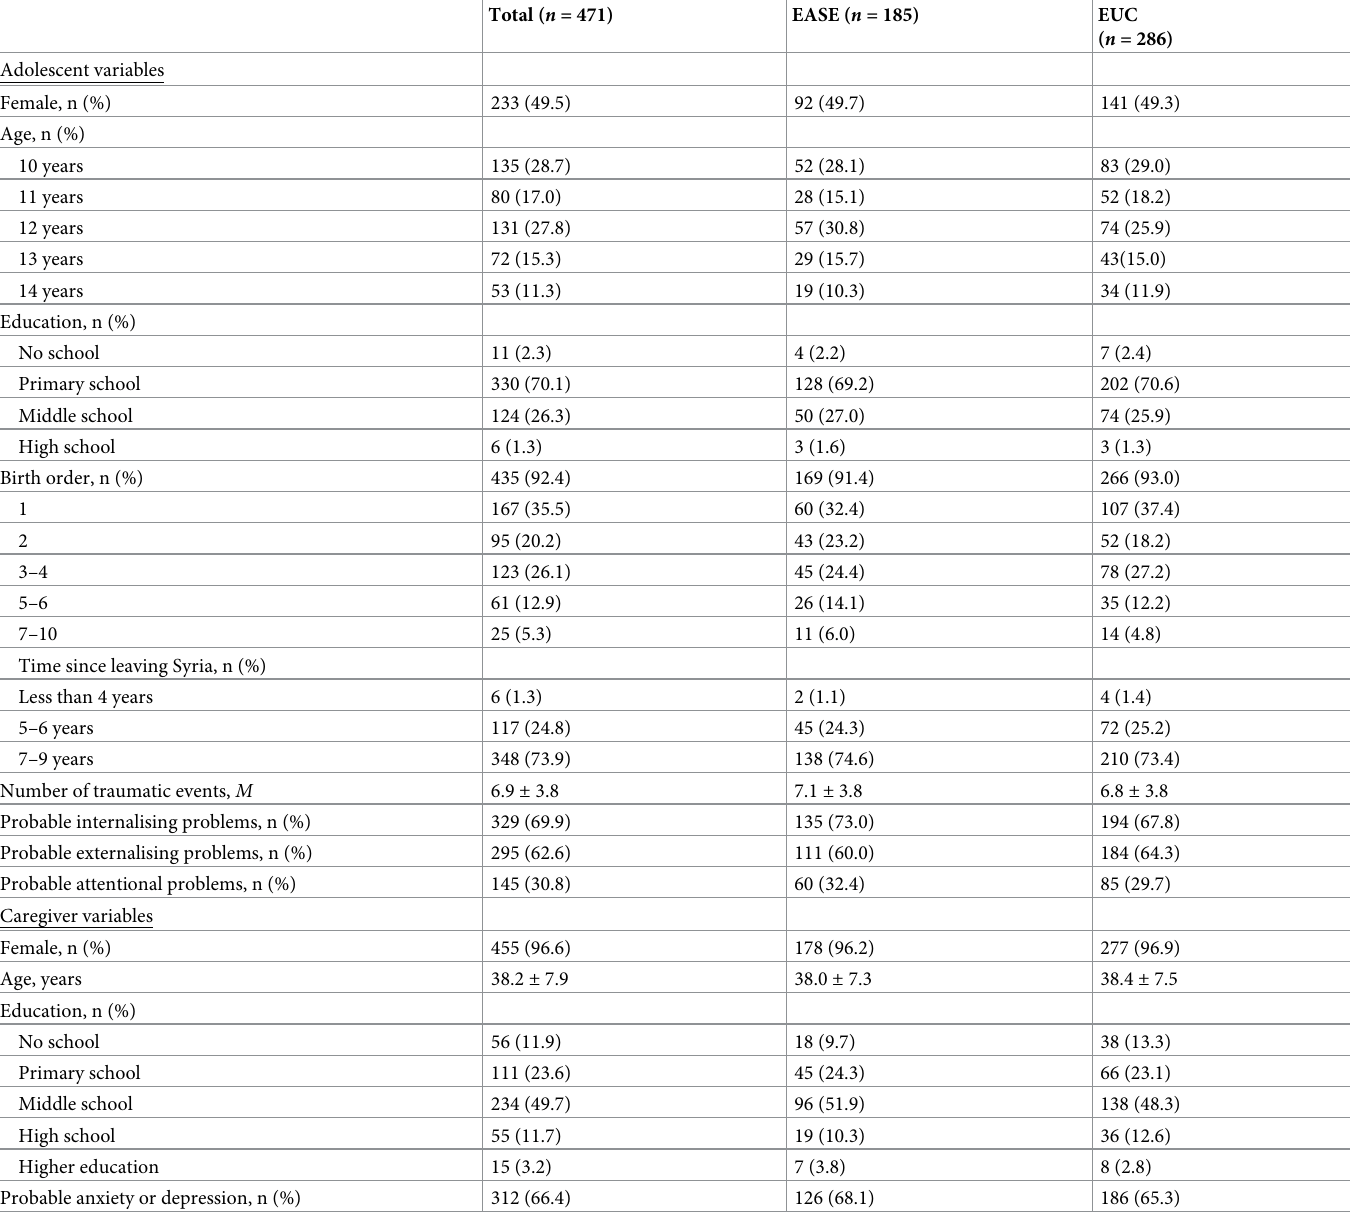
Table 1. Participant